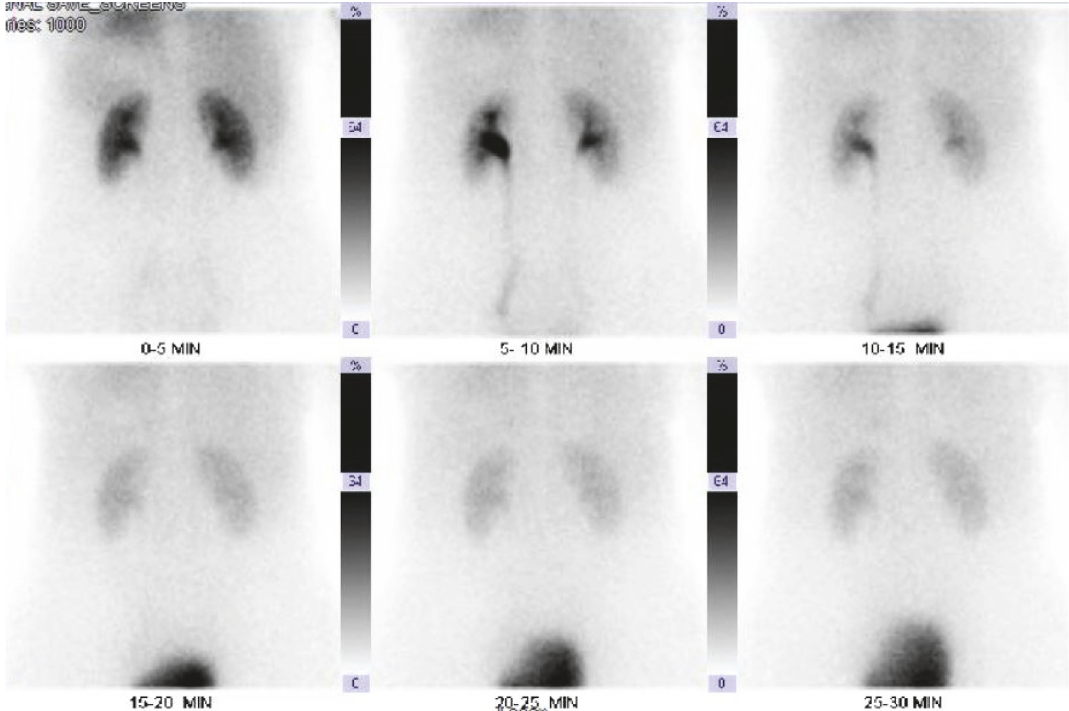
Figure 6: Renal scan: initial findings show mild asymmetrical activity in the left ureter compared to the right. However, washout at 20 min is symmetrical bilaterally without any signs of obstruction.